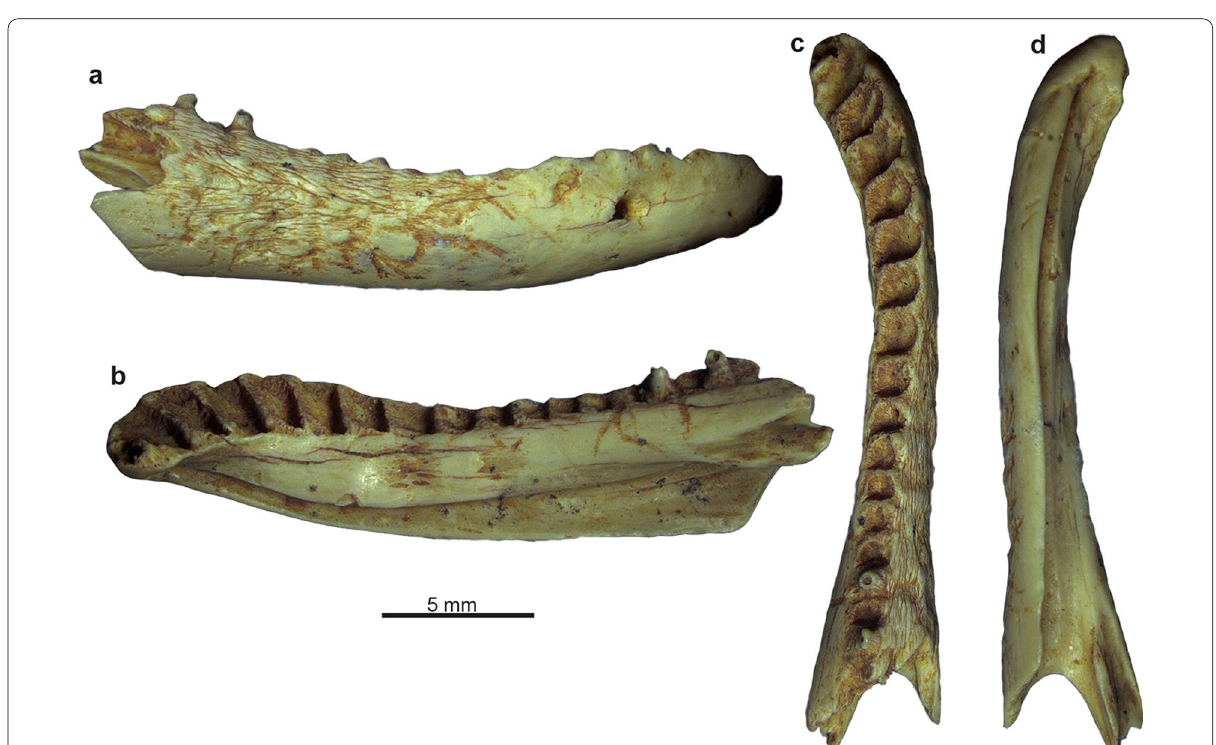
Fig. 99 Phosphoroboa filholii comb. nov. from imprecisely known localities in the Phosphorites du Quercy: right dentary (NHMW 2019/0020/0002) in labial ( a ), medial ( b ), dorsal ( c ), and ventral ( d )